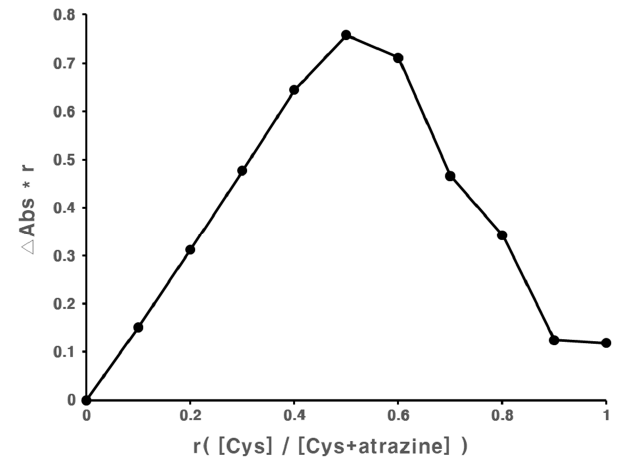
Figure 3. Job’s plot for atrazine and Cys.